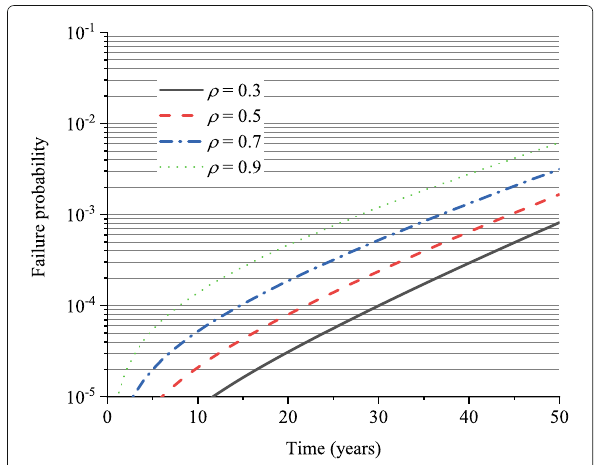
Fig. 11 Dependence of failure probability of a weighted 4-out-of-5 system on ρ